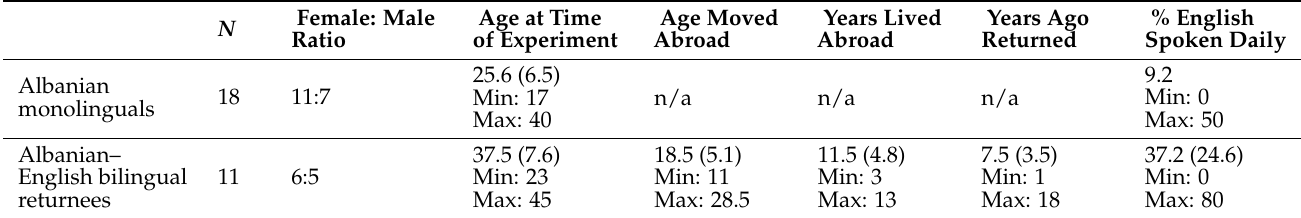
Table 2. Participant background summary